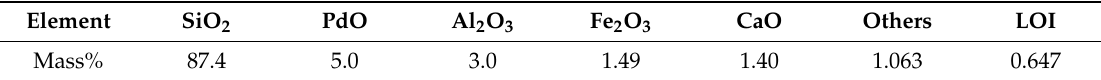
Table 4. Composition in